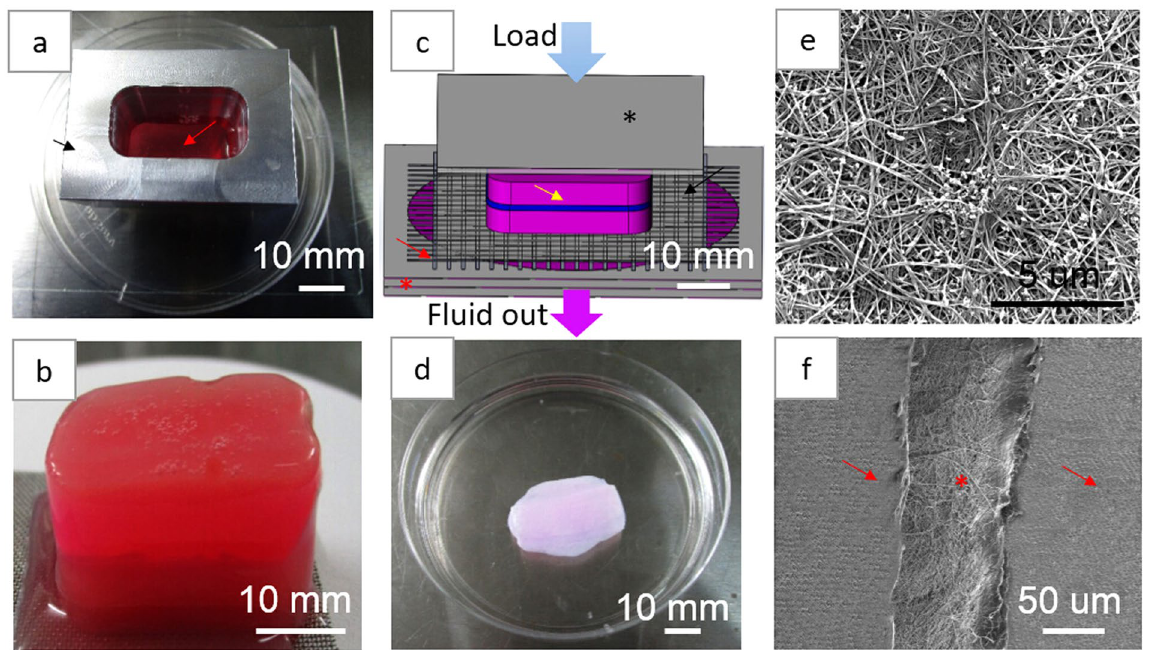
Figure 4. The hybrid scaffold production process: ( a ) PC collagen mold (black arrow) and collagen hybrid solution (red arrow); ( b ) hybrid scaffold construct gel; ( c ) schematic of the compression process of hybrid gel (yellow arrow) with glass plate (black asterisk), nylon mesh (black arrow), stainless steel mesh (red arrow) and filter papers (red asterisk); ( d ) hybrid scaffold; ( e ) SEM image of the hybrid scaffold surface; and ( f ) the oblique section of the hybrid scaffold, showing the three-layered structure with electrospun mat (red asterisk) and collagen layers (red